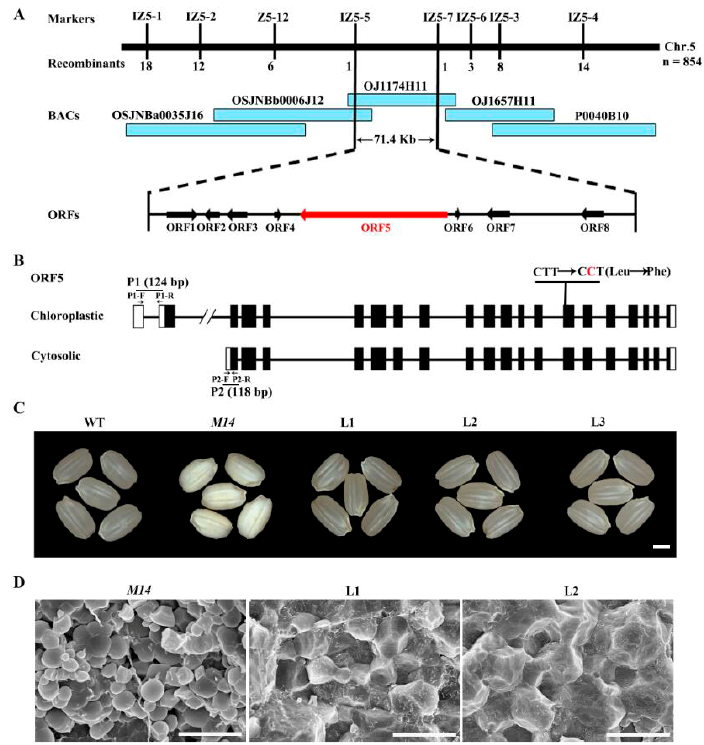
Figure 4. Map-based cloning and complementation of M14 . ( A ) Fine mapping of the OsPPDKB locus (red arrow). The OsPPDKB locus is mapped to a 71.4 kb region on chromosome 5, which contains eight predicted ORFs. ( B ) Structure of the OsPPDKB gene and positions of mutant site and qRT-PCR primers. The sequence of P1 (124 bp) was amplificated by specific primers P1-F and P1-R and the sequence of P2 (118 bp) was amplificated by specific primers P2-F and P2-R. ( C , D ) Complementation test of the OsPPDKB gene completely rescues the seed appearance ( C ) and compound starch granule arrangement ( D ) of M14 . Bars = 2 mm ( C ) and 10 μ m ( D ).